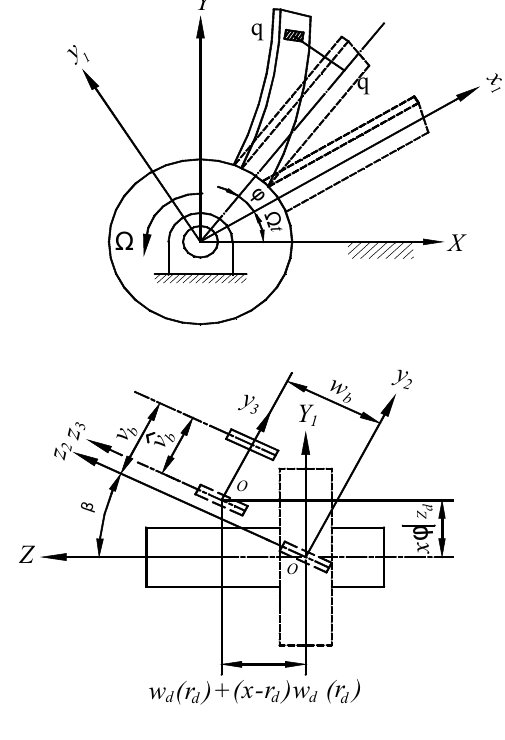
Fig. 3. Coordinate sets and deformation of a